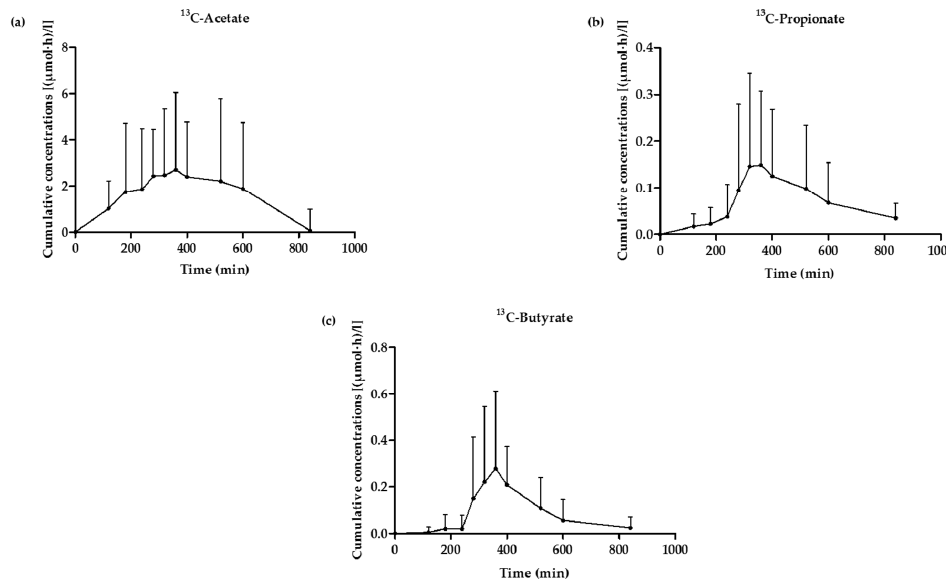
Figure 7. Average plasma concentrations of 13 C-acetate ( a ), 13 C-propionate ( b ) and 13 C-butyrate ( c ) originating from the colon as a function of time ( n = 40). Nutrients 2017 , 9 , 83